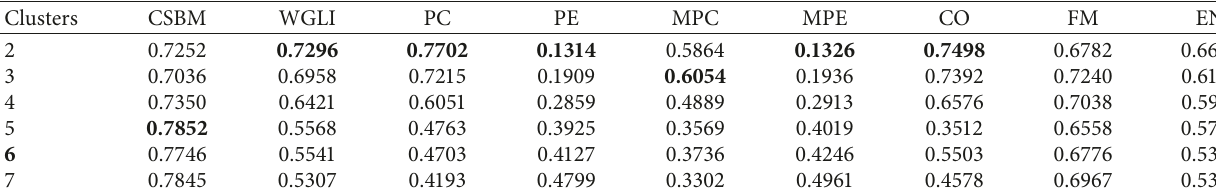
Table 8: Values of each index on the glass